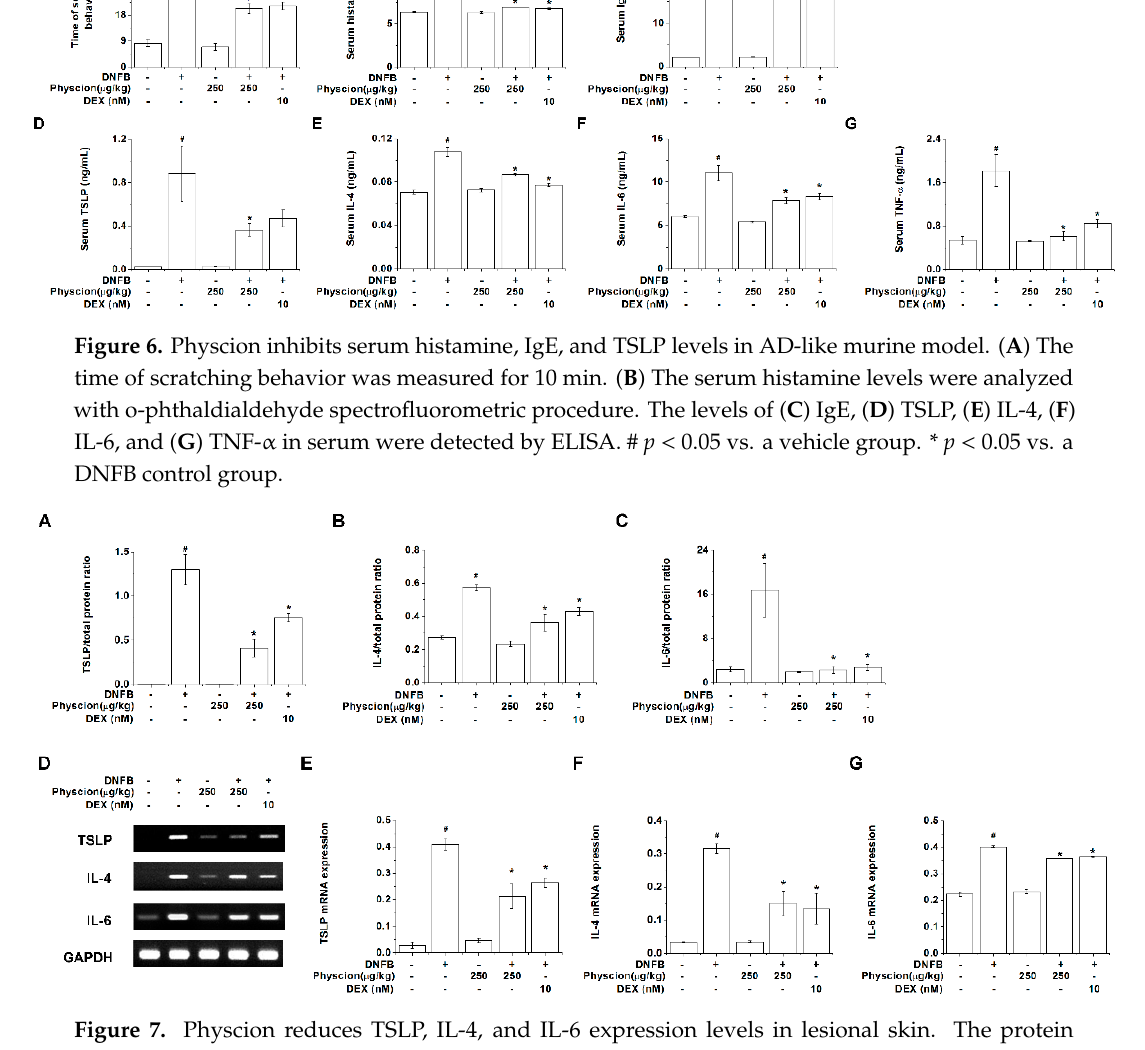
Figure 6. Physcion inhibits serum histamine, IgE, and TSLP levels in AD-like murine model. ( A ) The time of scratching behavior was measured for 10 min. ( B ) The serum histamine levels were analyzed with o-phthaldialdehyde spectrofluorometric procedure. The levels of ( C ) IgE, ( D ) TSLP, ( E ) IL-4, ( F ) IL-6, and ( G ) TNF- α in serum were detected by ELISA. # p < 0.05 vs a vehicle group. * p < 0.05 vs a DNFB control group.